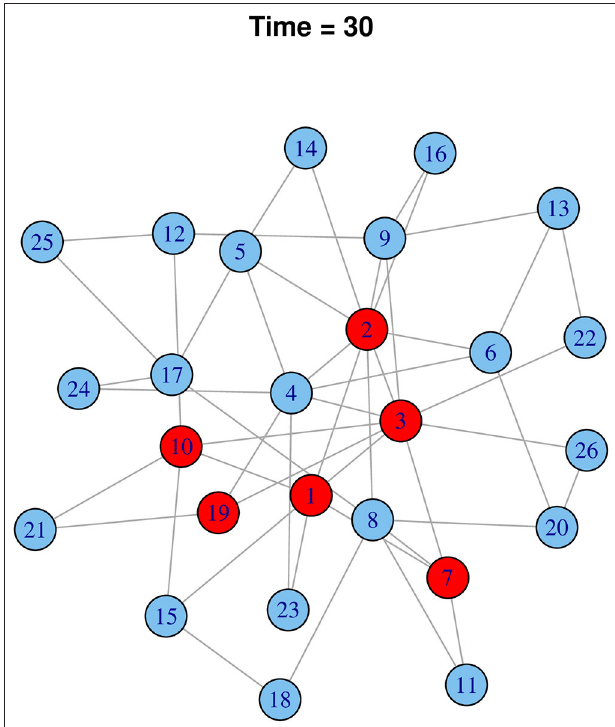
FIGURE 10 | Effect of controlling “fast” pathogen ( R o 3) when infectiousness is reduced to 25% ( R o 0.75) after 30-time steps. Infected nodes are shown in red and uninfected in